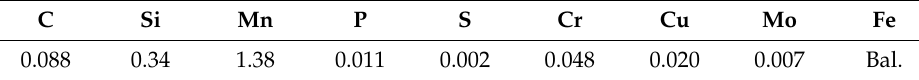
Table 1. Chemical composition (in wt. %).